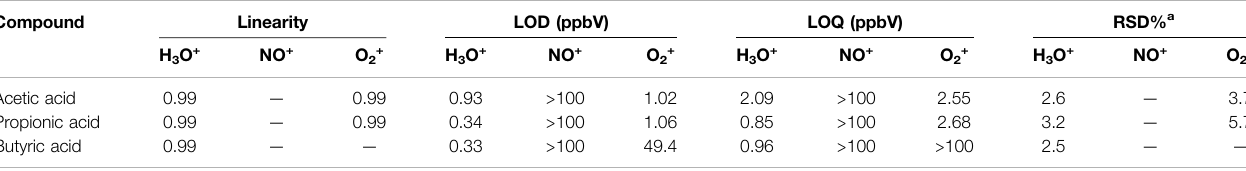
TABLE 2 | Figures of merit for the analysis of acetic acid, propionic acid, and butyric acid. Compound Linearity